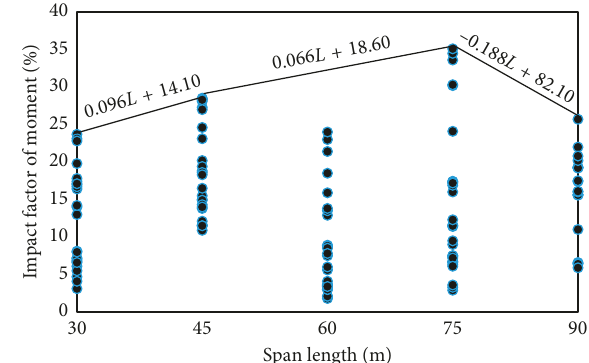
Figure 11: Bending moment dynamic impact factor versus span length.